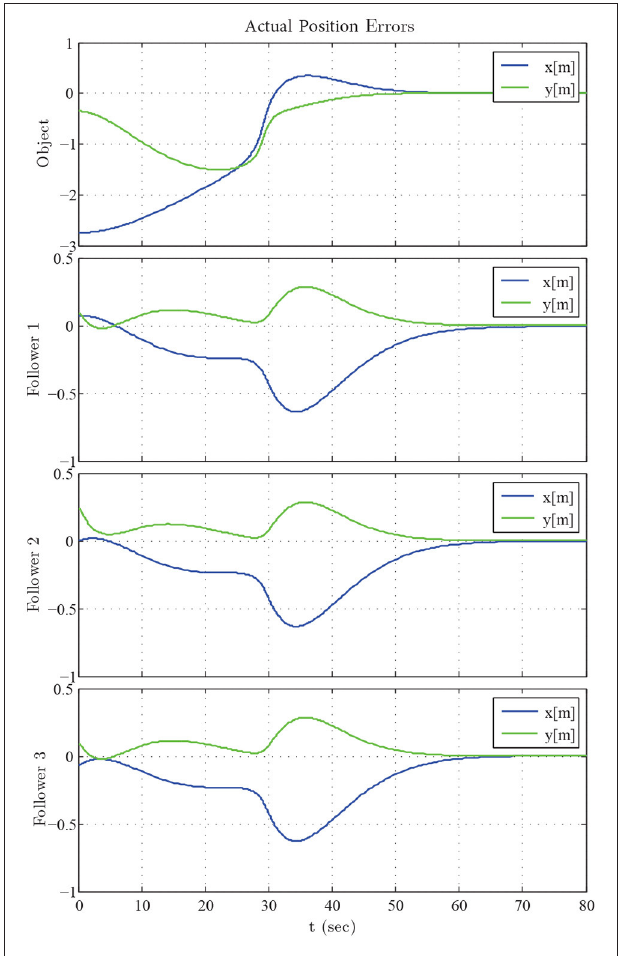
FIGURE 7 | The actual position errors to the desired configuration. FIGURE 8 | The control input signals U L and U F